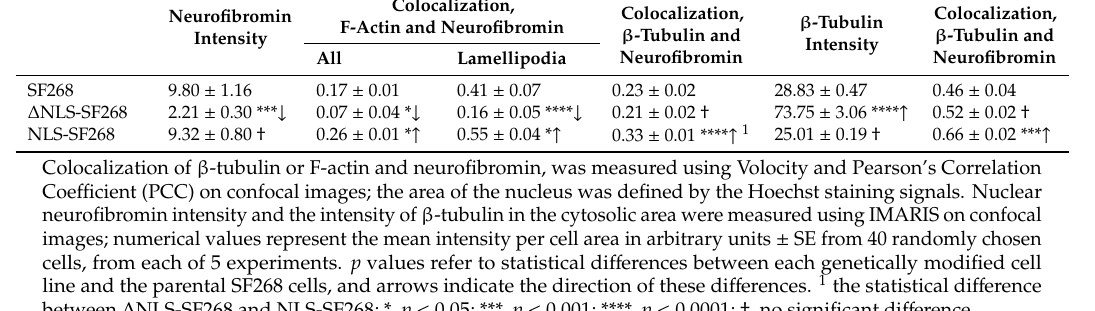
Table 1. Quantitative intensity and colocalization analysis. Nucleus Cytosolic Area Spindle Neurofibromin